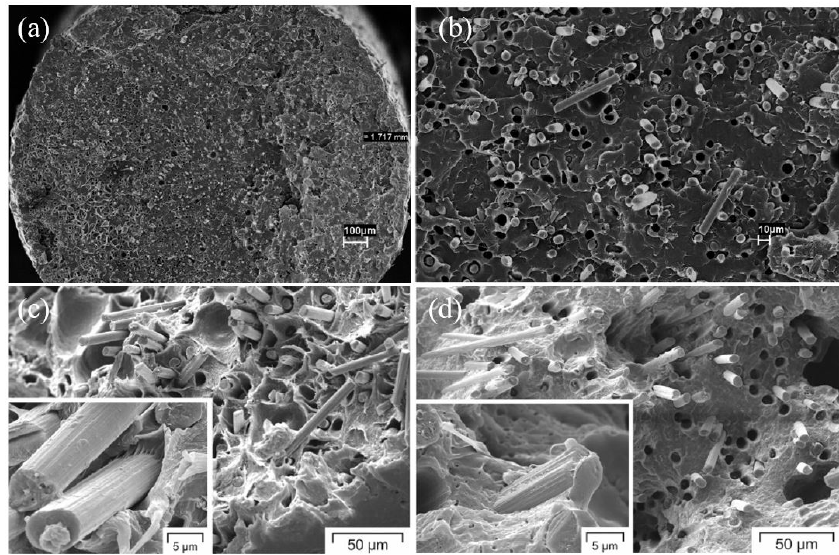
Figure 15. ( a ) Cross-section of CF reinforced PLA filament. ( b ) Magnified cross-section of CF reinforced PLA filament. ( c ) Cryo-fractured surface of 15% CF reinforced PP composite. ( d ) Cryo-fractured fractured surface of 20% CF reinforced PP composite. ( a ),( b ): [69], ( c ),( d ): [153].